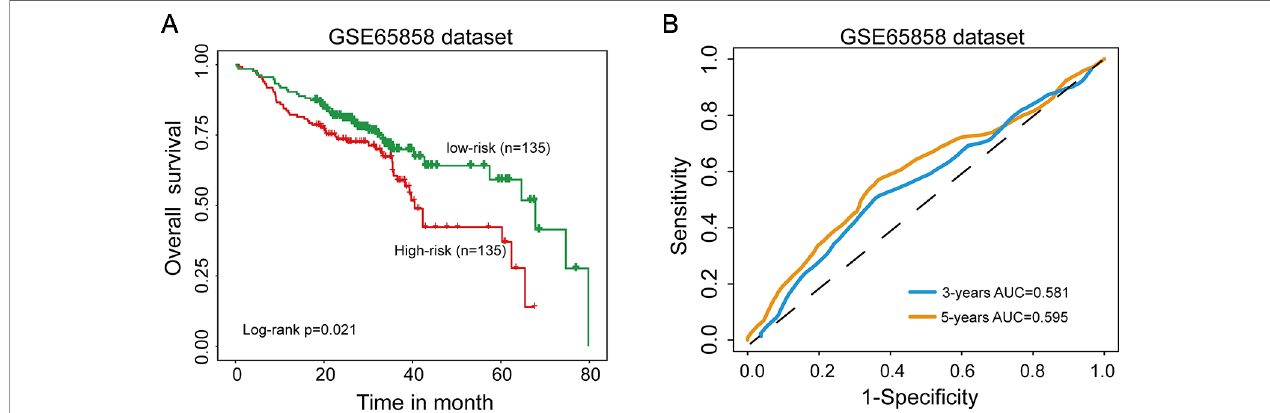
FIGURE 4 | Independent validation of the 15SigRS in the Gene Expression Omnibus (GEO) data set. (A) Kaplan – Meier survival curves of overall survival between the high-risk group and low-risk group in the GSE65858 data set. (B) Time-dependent ROC analysis at 3 and 5 years in the GSE65858 data set.